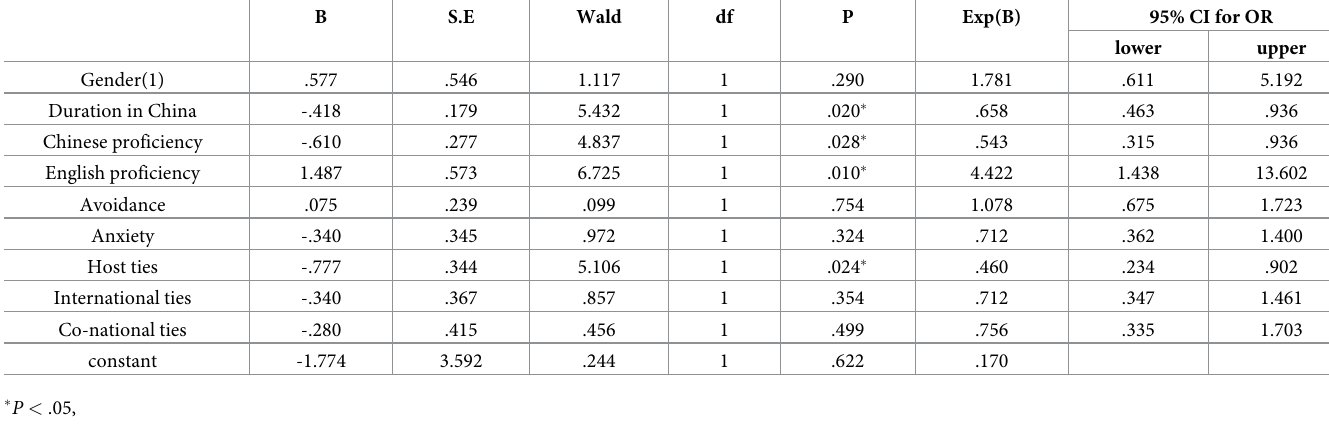
Table 6. Logistic regression predicting likelihood of adopting marginalization